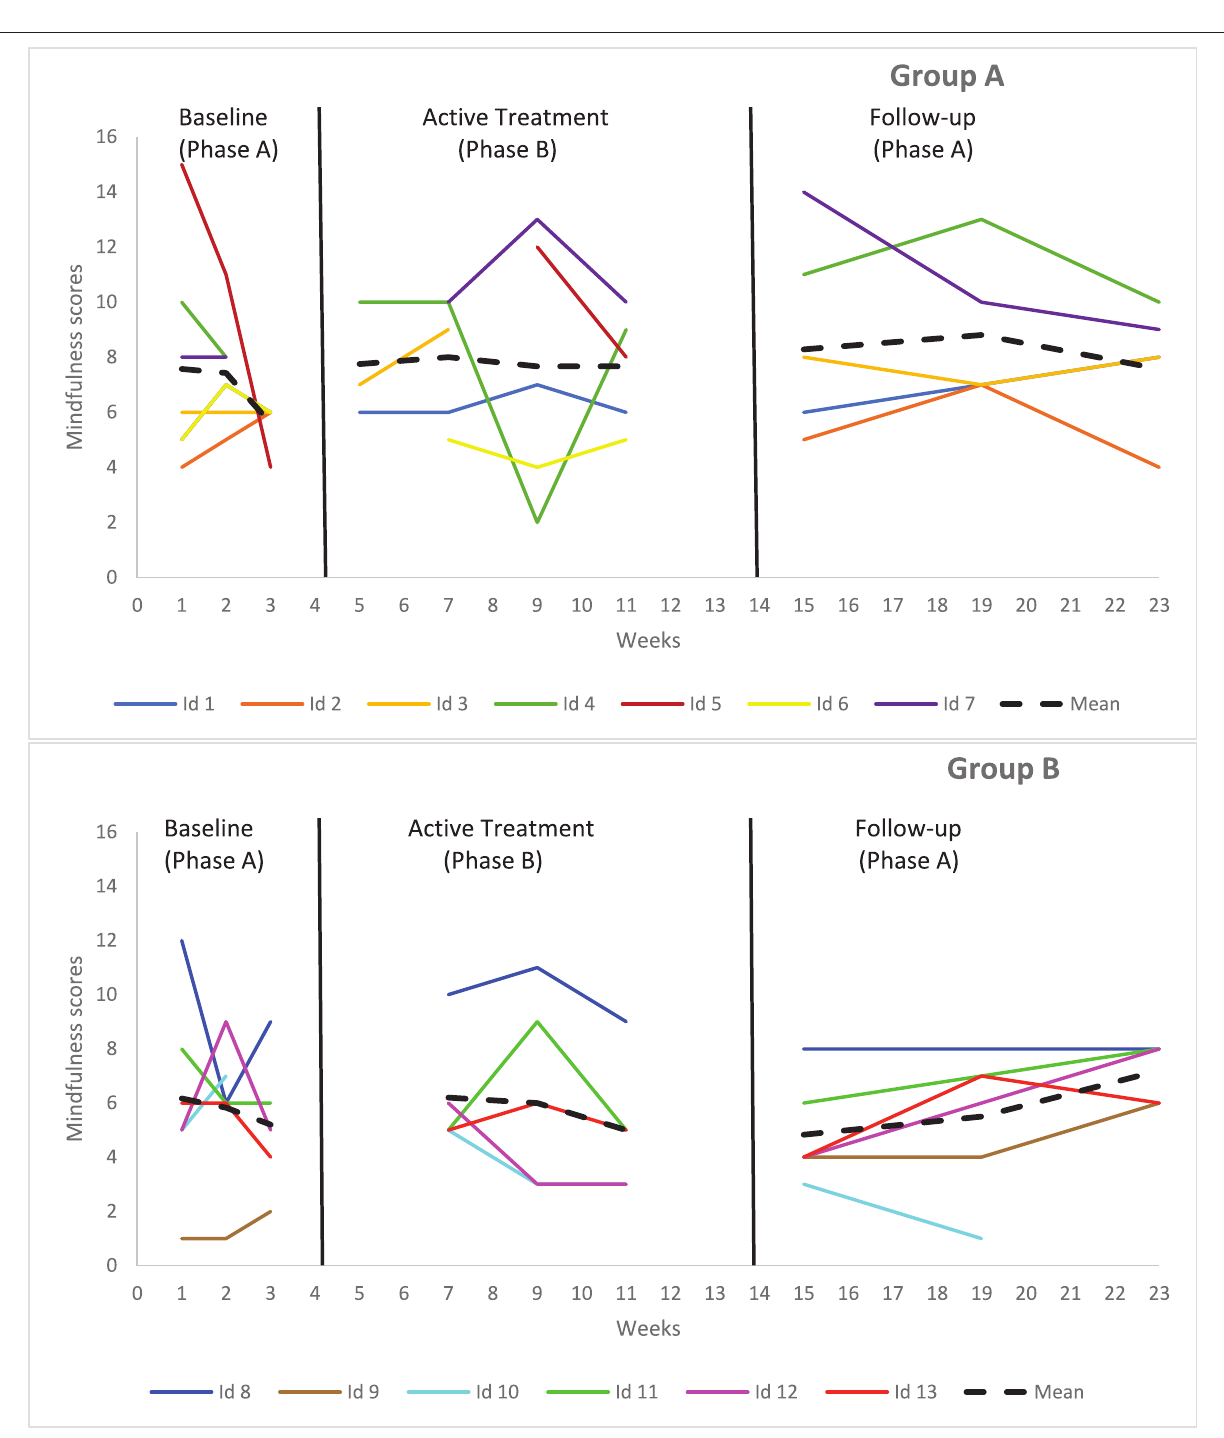
would be to assess teacher expectations at